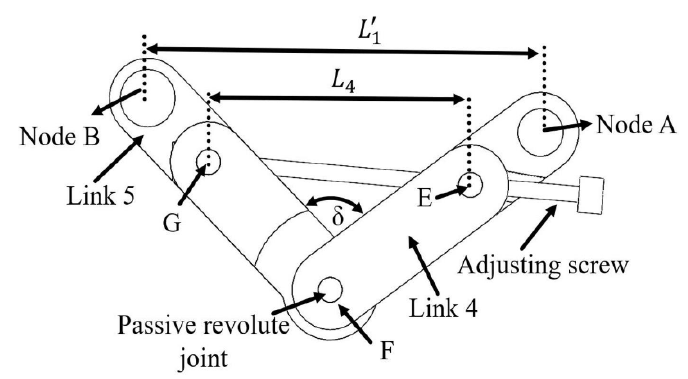
Figure 5. The variable-length crank C.